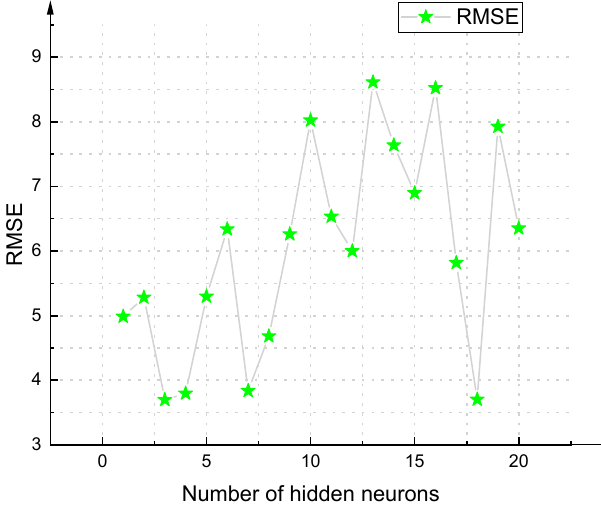
Figure 18. RMSE value of BPNN model based on Log-Sigmoid (single hidden layer).